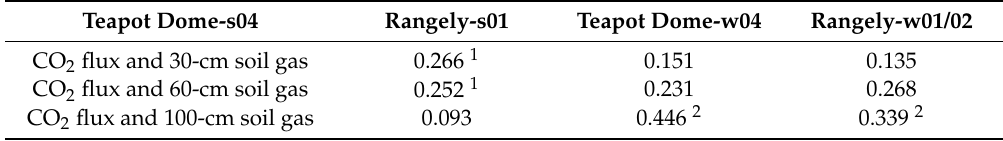
Table 3. Correlations between gas fluxes and soil gas concentrations at Rangely and Teapot